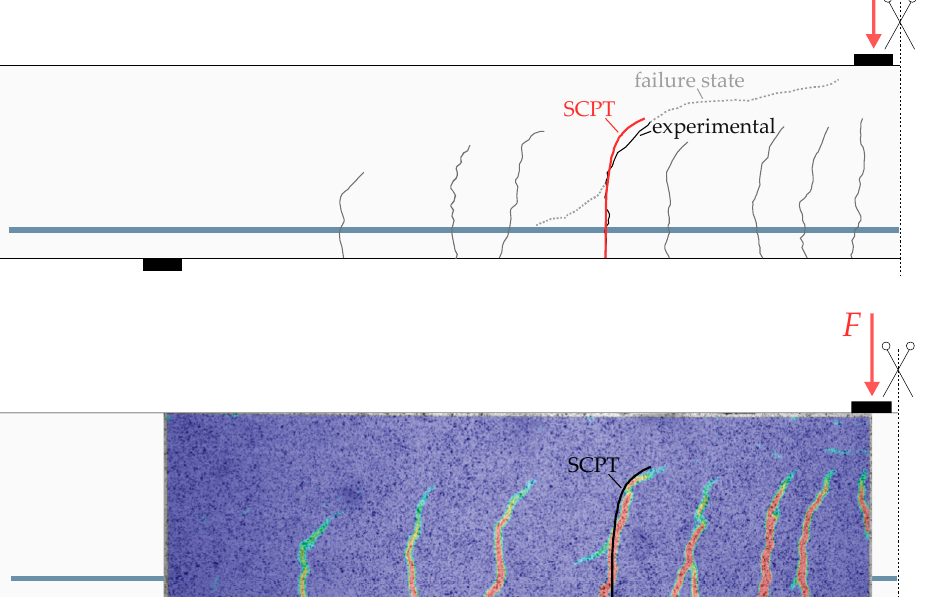
Figure 8. Comparison of the calculated SCPT failure shear crack with the experimentally obtained crack pattern: ( top ) marked crack pattern and ( bottom ) digital image correlation (DIC) measurements at the opposite side.